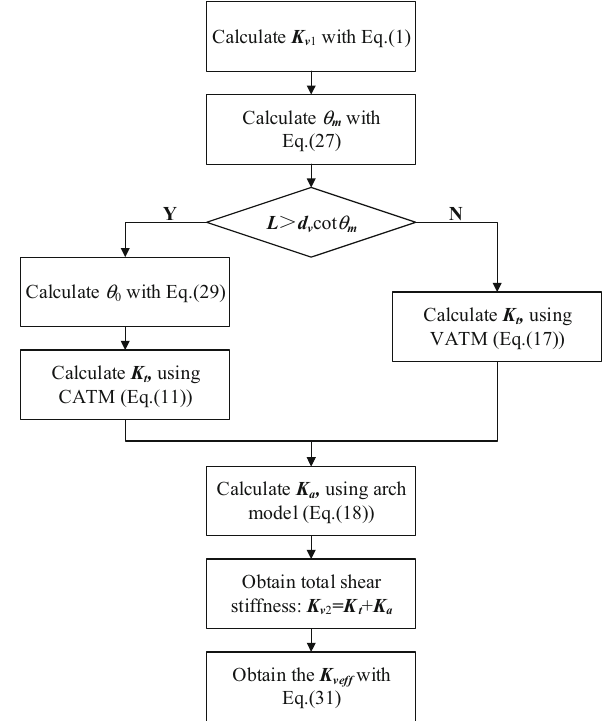
Fig. 7 Flowchart showing solution algorithm for effective shear